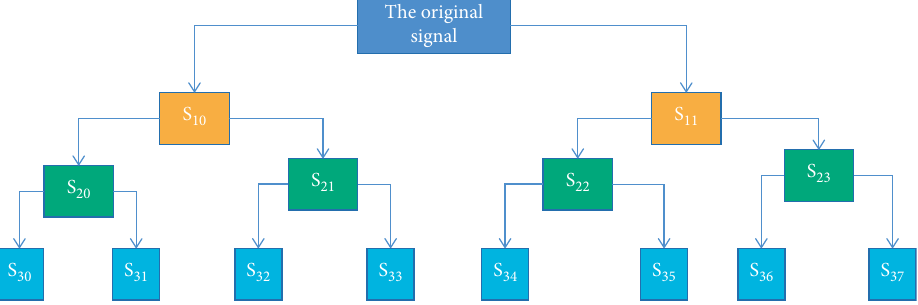
Figure 2: Schematic diagram of wavelet packet